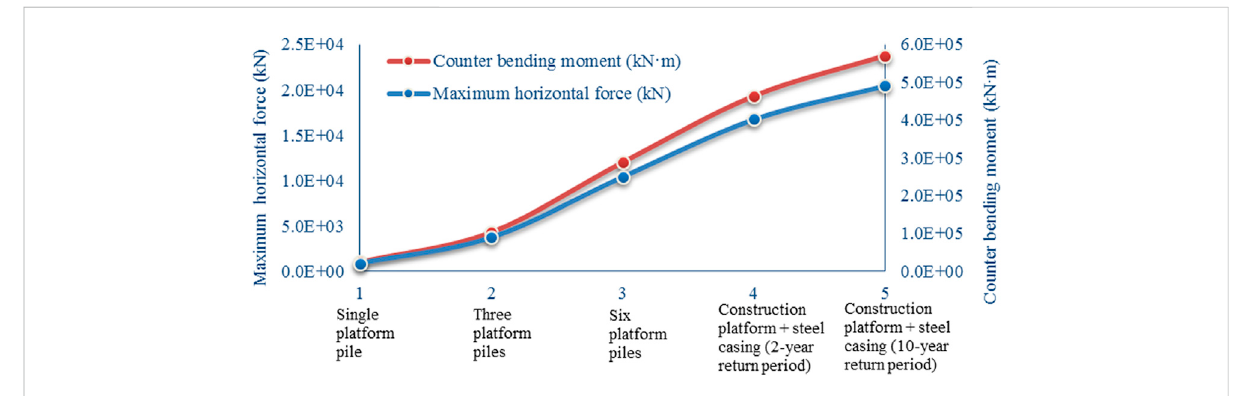
FIGURE 15 Maximum horizontal force and bending moment of the overall structure in different